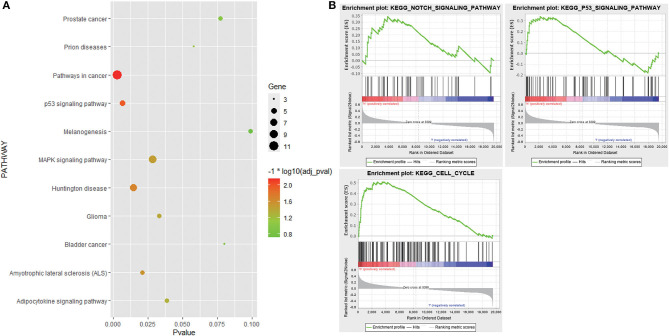
Functional enrichment analysis. (A) Bubble chart showing Kyoto Encyclopedia of Genes and Genomes (KEGG) pathways that 152 genes in the candidate module were enriched in. (B) KEGG pathways enriched in the high-risk group based on stratified gene set enrichment analysis (GSEA).